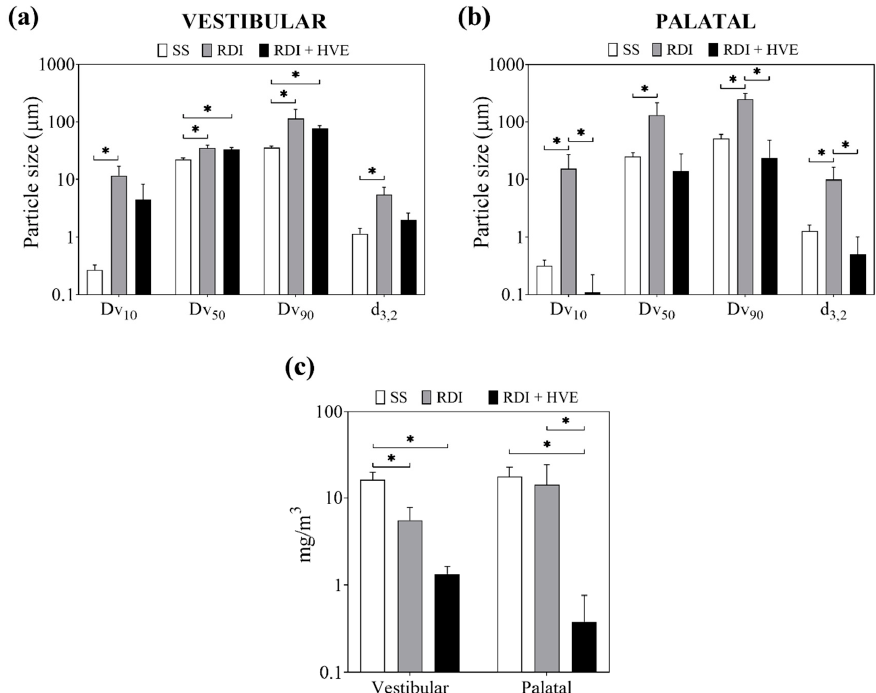
Figure 3. Rubber dam isolation and high-volume suction reduce dental aerosol particles. The distribution by volume (Dv) parameters for percentiles 10, 50 and 90 are shown for the vestibular side in plot ( a ) and the palatal side in plot ( b ). For these three percentiles, there is an increase in the average size of the particles based on the volume percent when the RDI is implemented. A significant increase in the d 3,2 (the average size of particles below 10 μ m) is observed with the use of the RDI, but no effect is detected in the RDI + HVE group, when compared with the SS group. ( c ) The RDI and the RDI + HVE strategies reduce the concentration of aerosol-generating procedures (AGPs) in the vestibular side when compared with the SS group. In contrast, the RDI + HVE reduce this parameter when compared with both the SS group and the RDI group, in the palatal side. Results are shown as mean ± SEM; n = 3; *: p < 0.05. Abbreviations: SS, standard suction; RDI, rubber dam isolation; HVE, high-volume evacuator. The Y axis of ( a ), ( b ) and ( c ) is Log 10 scaled. To determine the effect of the mitigation strategies on the average size of the particles below 10 μ m for each condition, the Sauter mean diameter (d 3,2 ) was determined. For the SS group, the d 3,2 was significantly lower than the RDI group in both vestibular side and palatal side ( p < 0.05) whereas the d 3,2 of the RDI group was significantly higher than the RDI + HVE group in the palatal side (Figure